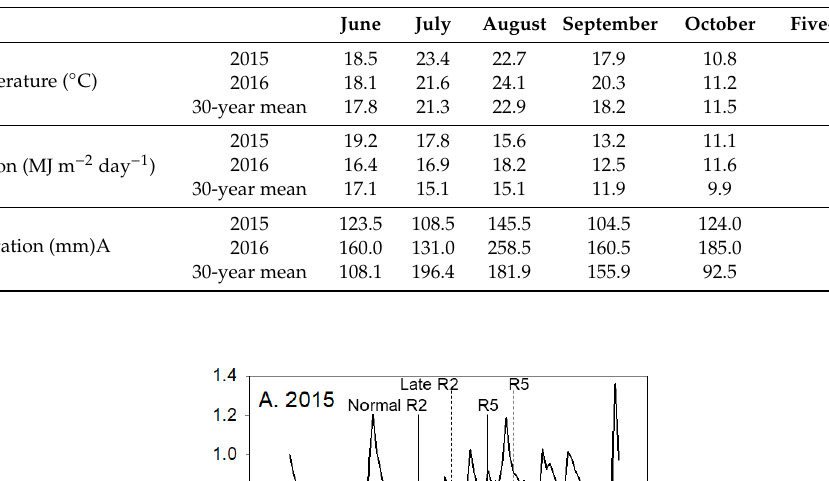
Table 1. Monthly and five-month (June–October) mean air temperature (°C), solar radiation (MJ m − 2 day − 1 ), and total precipitation (mm) in soybean fields during the 2015 and 2016 growing seasons compared with the 30-year means in the Tohoku region of northern Japan.